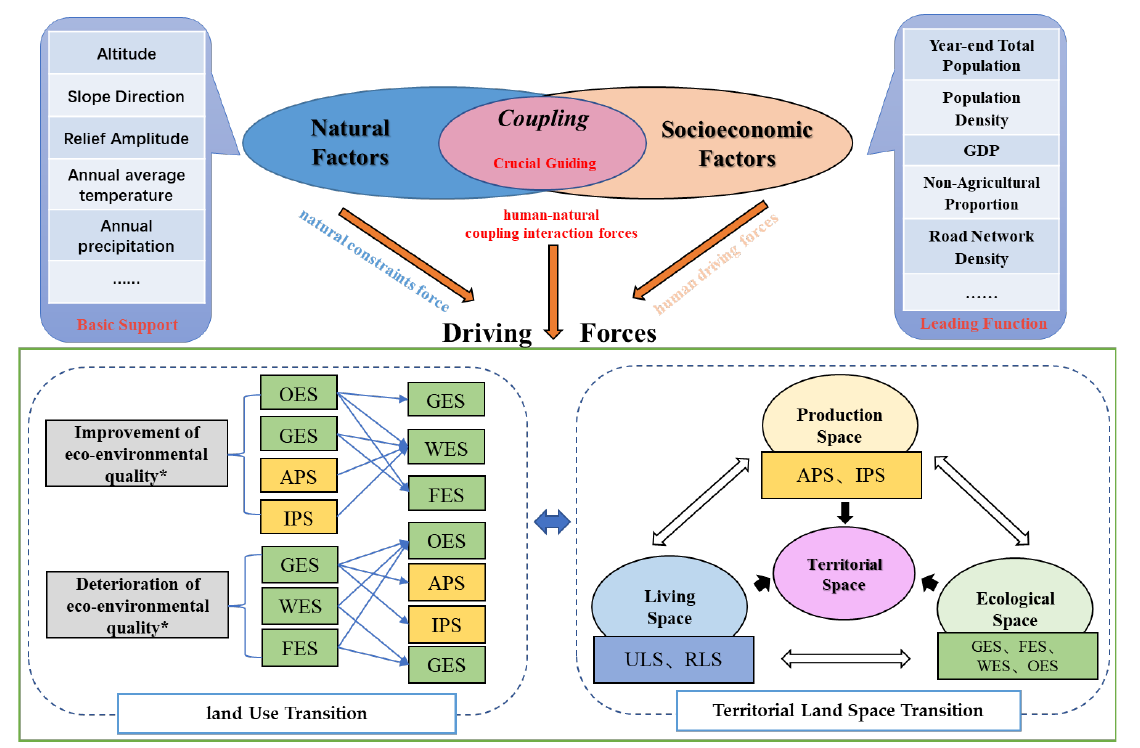
Figure 7. Mechanism of eco-environmental quality change under territorial spatial evolution in Qinghai.